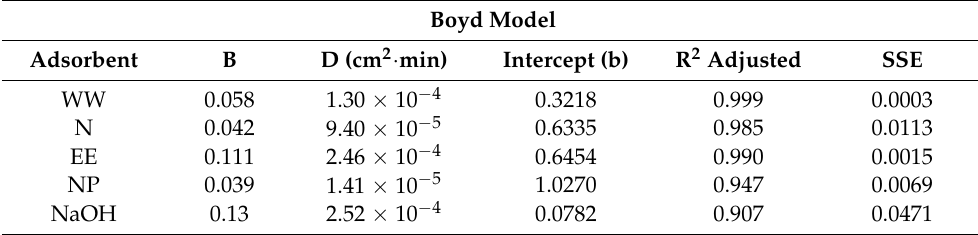
Table 3. Boyd’s Intraparticle Diffusion model parameters for stage I (initial